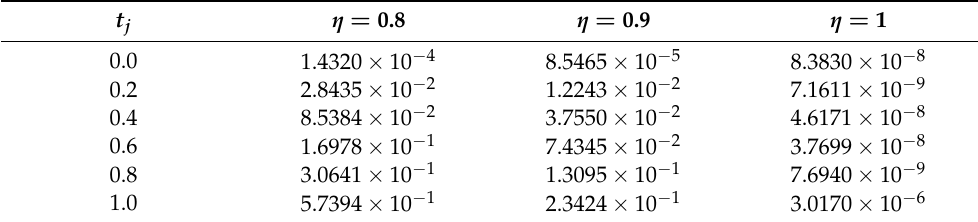
Figure 6. Approximate solutions for various values of η and N = 6 for Example 3. Table 2. Absolute errors at equally spaced points for N = 6 for Example